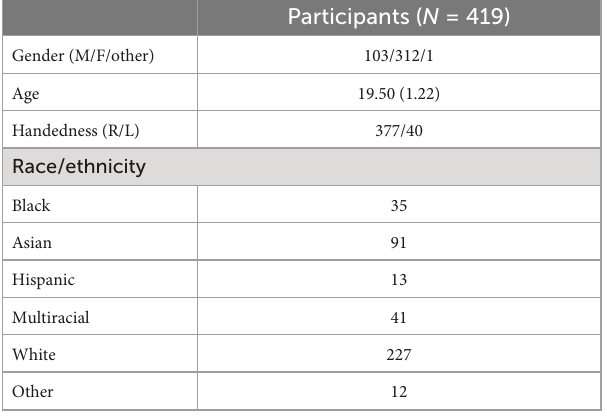
TABLE 1 Demographic information for study